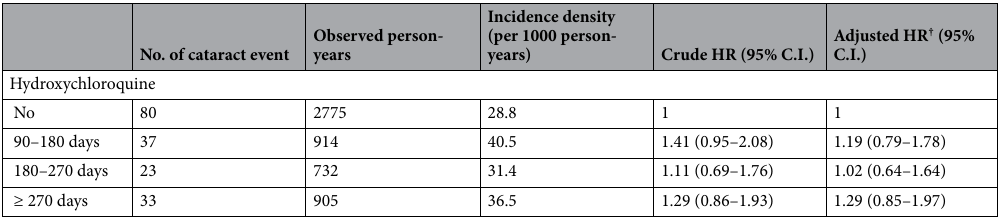
Incidence density (per 1000 person- years)